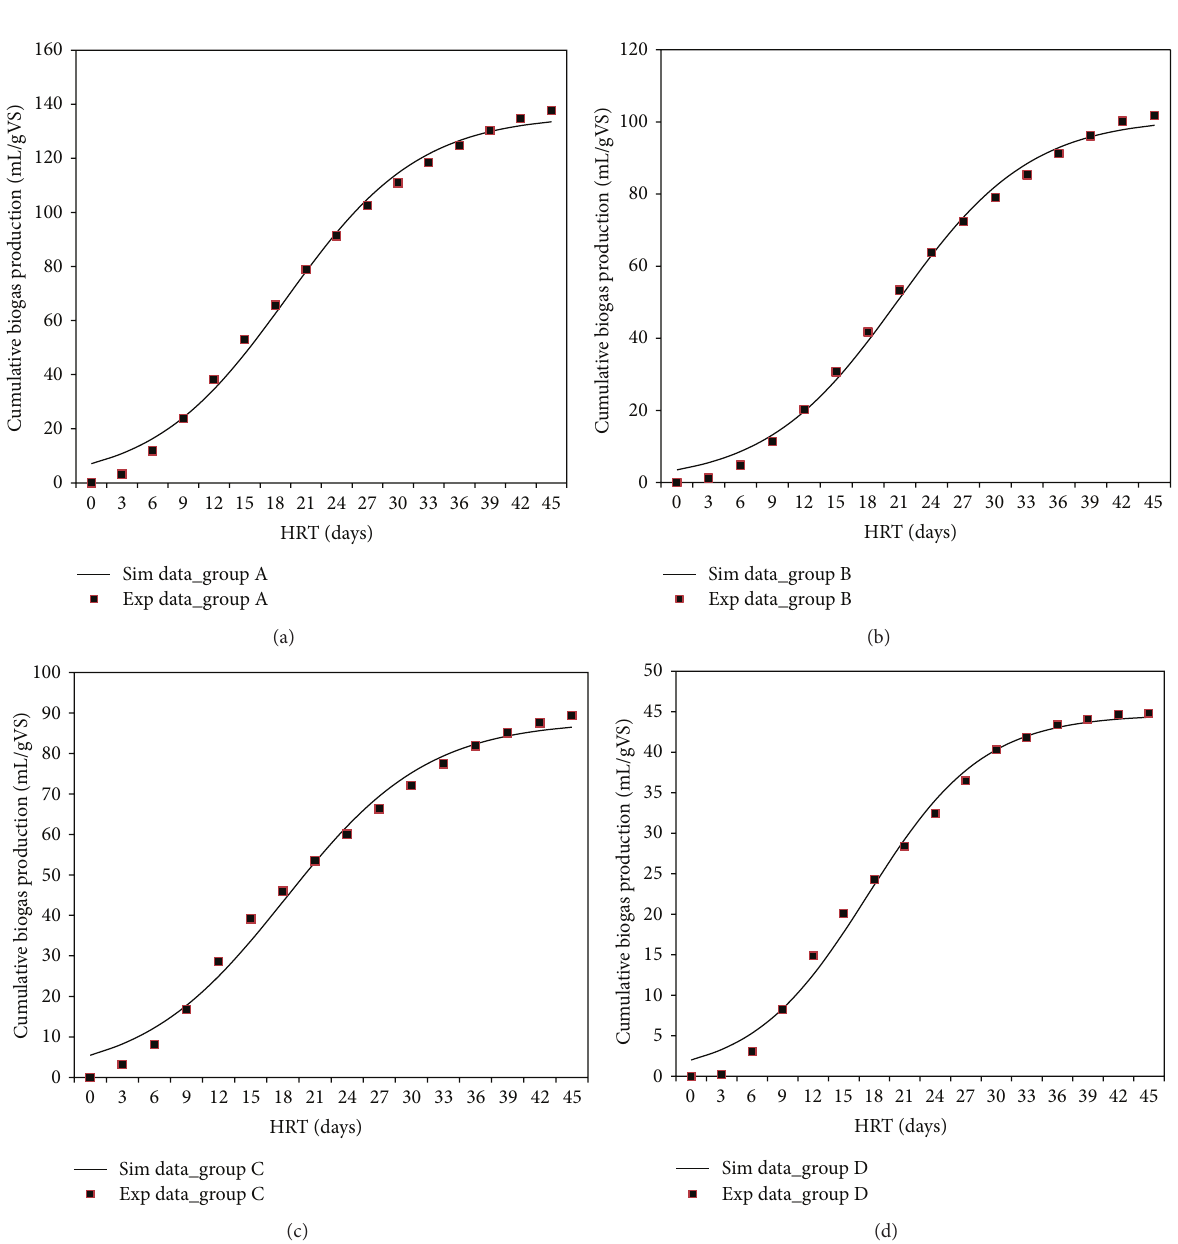
TS (total solid) is expressed in Kg m −3 . Hence, 𝐶 𝑝